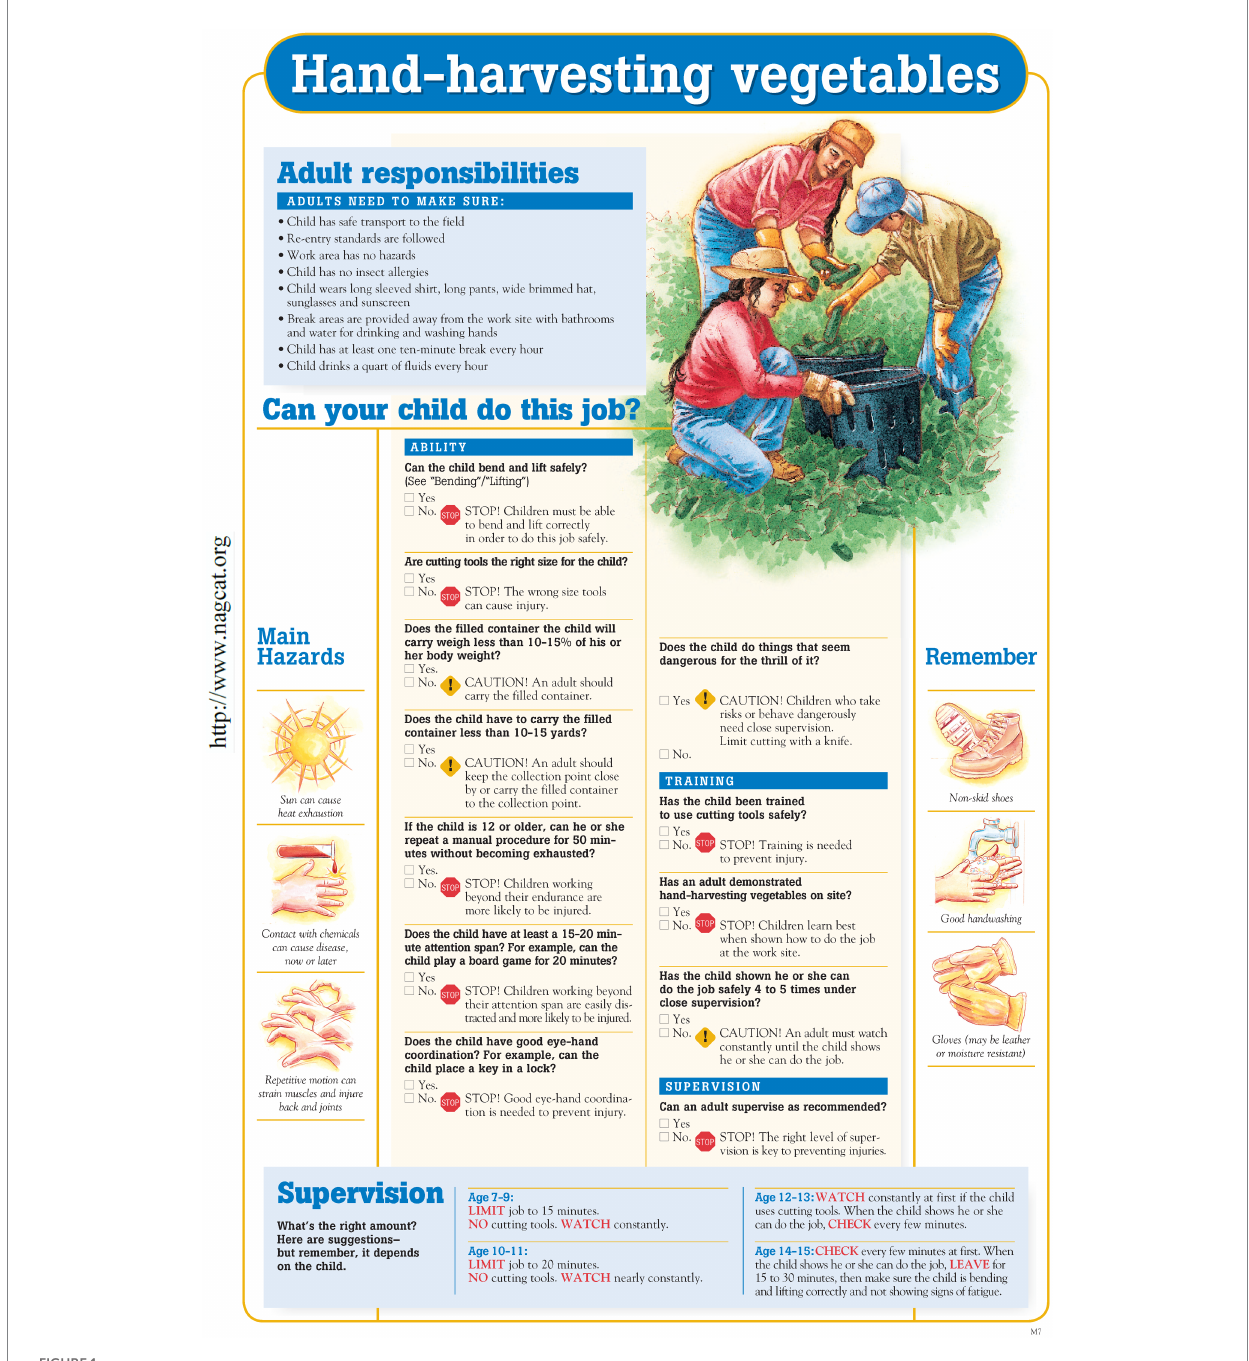
FIGURE 1 NAGCAT poster for hand-harvesting vegetables. Published with permission from the National Children’s Center for Rural and Agricultural Health and